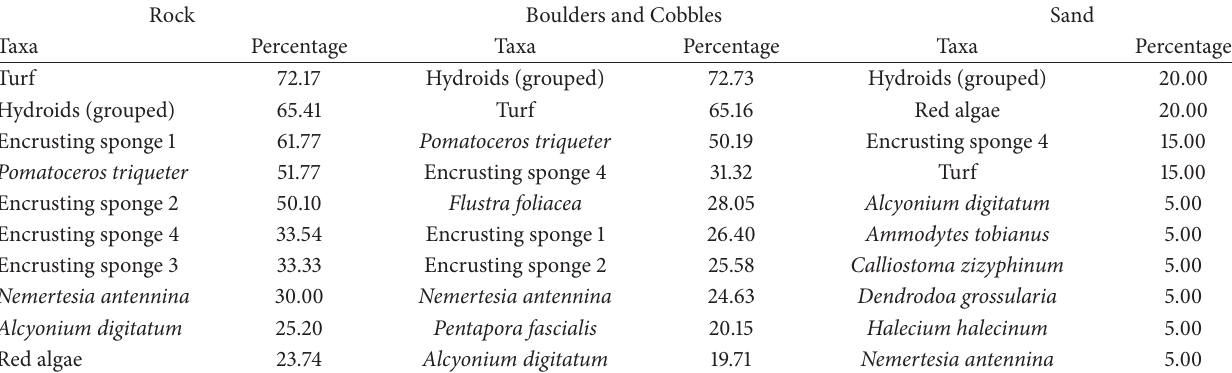
Table 4: The ten taxa from frame grab analysis with the greatest abundance where rock, boulders and cobbles, and sand were the dominant habitat type. Data are percentage of frames containing each taxa for each habitat type (%). Gravel and pebbles were excluded as they did not dominate the habitat in any frame.